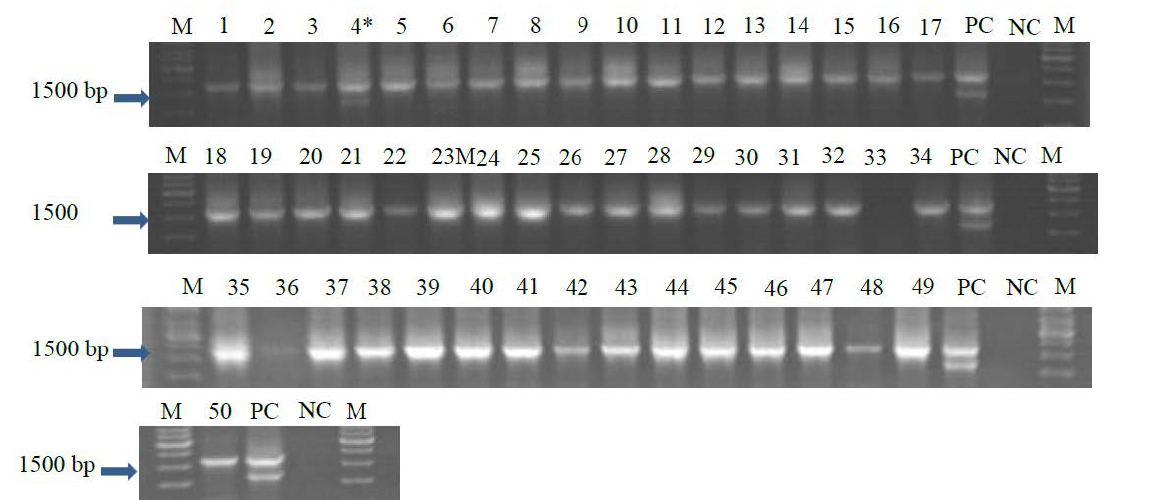
Fig. 4. PCR amplification of Pl 5 with the expected size of 1,500 bp (as indicated by arrow) using Hap3 primer pairs in 51 inbred lines. Only the number 4 inbred lines (as indicated by asterisk) showed the expected band. M: 1Kb marker, PC: positive control, NC: negative